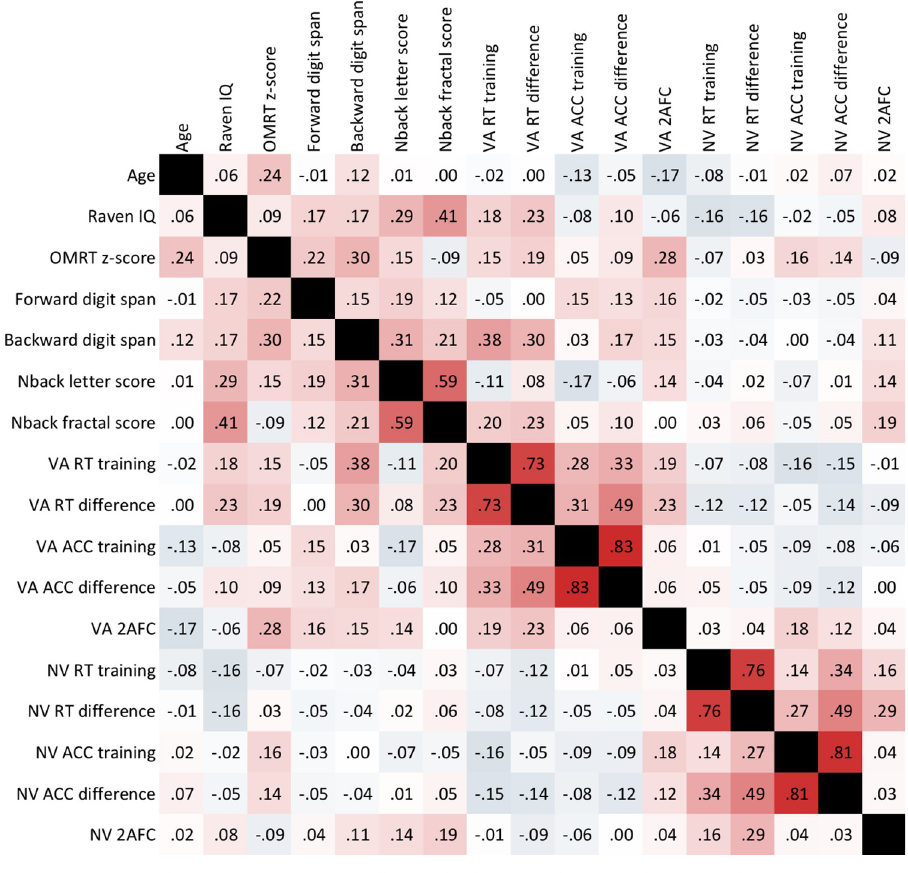
Fig 7. Correlations between age, IQ, reading fluency, background abilities and statistical learning measures. From the statistical learning measures, VA 2AFC was significantly related to the OMRT z-score on the level of p < .05.